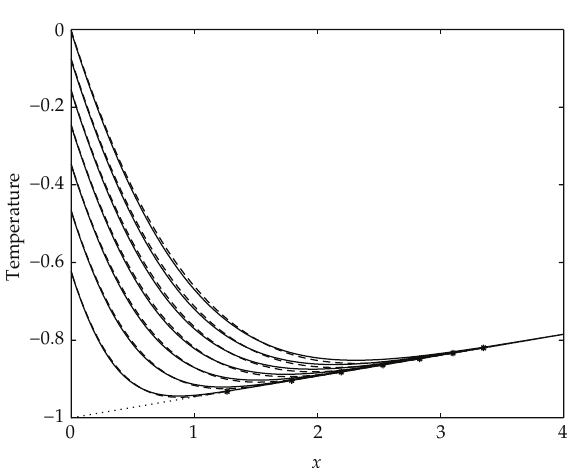
Figure 5: Solution profiles of the aircraft icing example before melting begins, at nondimensional times t (cid:8) 0 (cid:3) dotted line (cid:4) and t (cid:8) 0 . 1 , 0 . 2 , 0 . 3 , 0 . 4 , 0 . 5 , 0 . 6 , 0 . 7. The solid line denotes the exact solution and the dashed line denotes the HBIM solution (cid:3) with n (cid:8) 3 . 535 (cid:4)